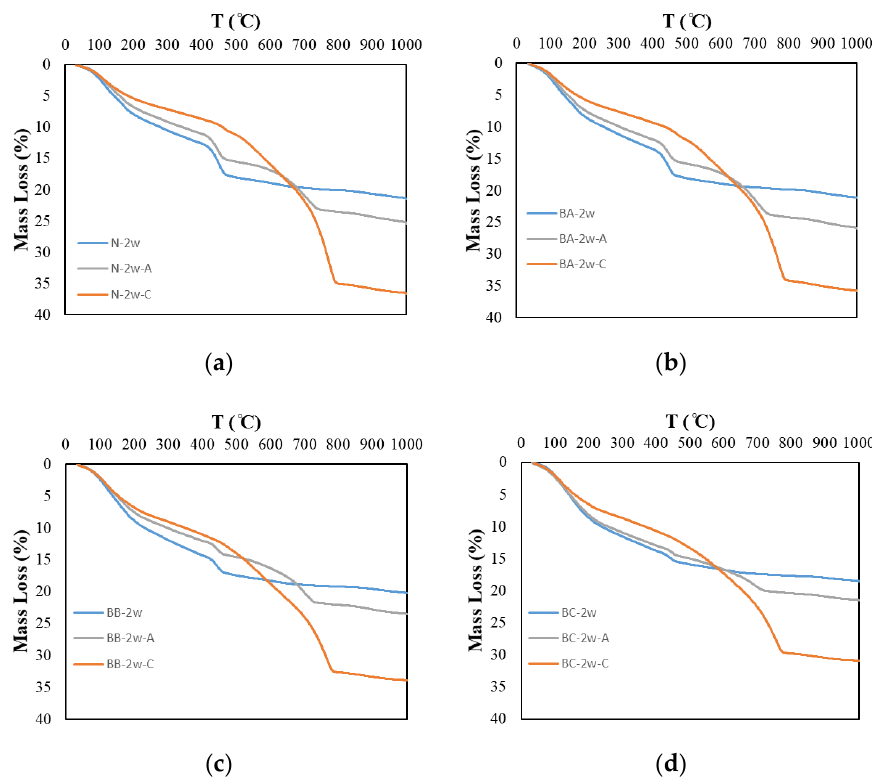
Figure 3. Mass loss of carbonated cement paste. ( a ) N; ( b ) BA; ( c ) BB and ( d ) BC.